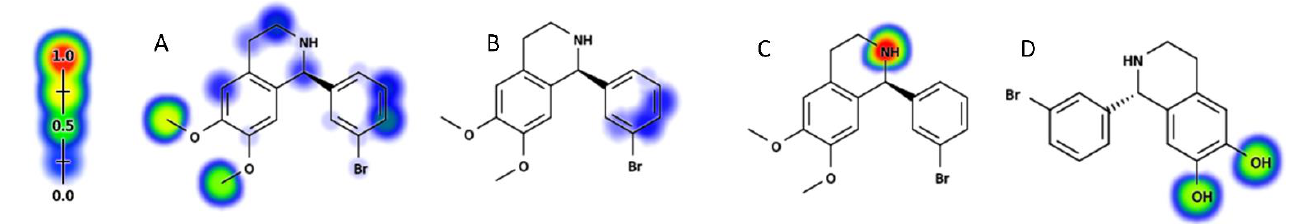
Figure 3. In silico prediction of ( A ) sites of metabolism in human liver microsomes; ( B ) site of epoxidation; ( C ) site of glucuronidation in 1 −(3′− bromophenyl) − heliamine; ( D ) site of glucuronidation in O-demethylated metabolite. Potential sites of metabolism are highlighted by a colour gradient, distributed throughout a range of 0 (no colour; minimal probability) to 1 (red colour; maximal probability).